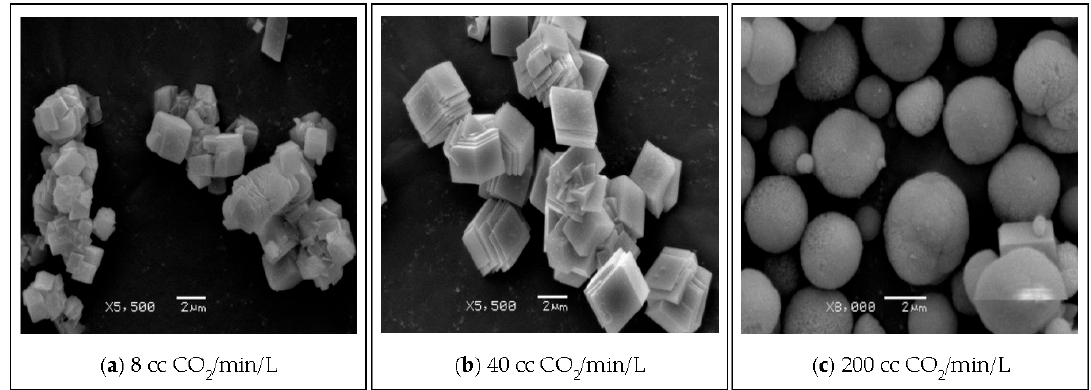
Figure 9. ( a – c ) The SEM images of CaCO 3 particles precipitated through the carbon mineralization processes (8, 40 and 200 cc CO 2 /min/L).